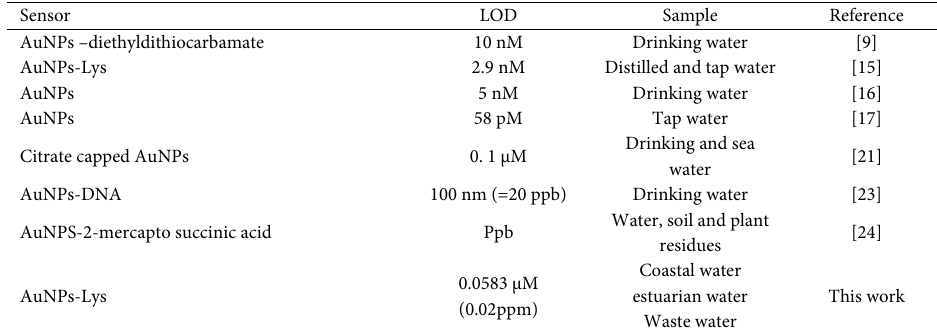
Table 4. Summary of nanoparticle-based sensor for Hg 2+ in